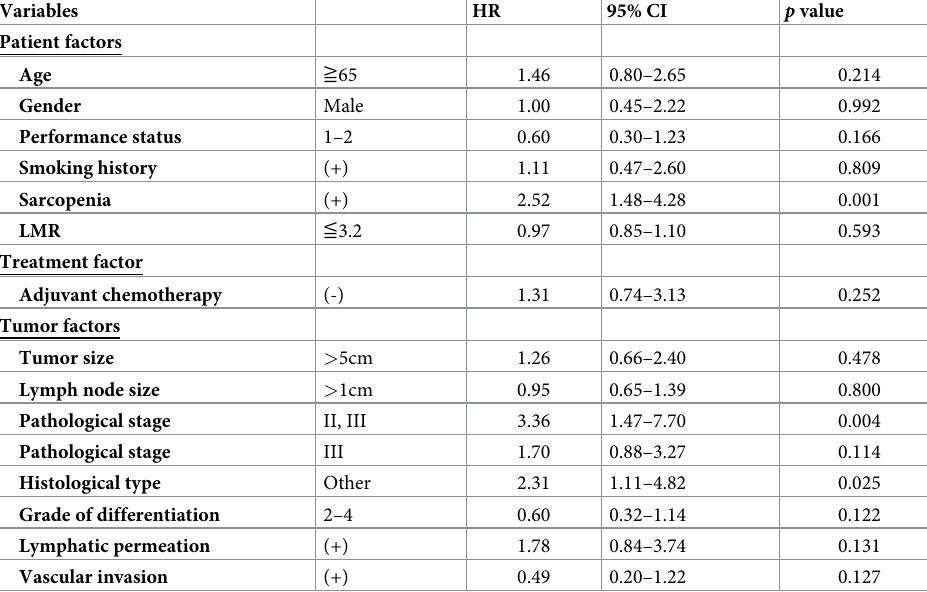
Table 3. Multivariate analysis on cancer